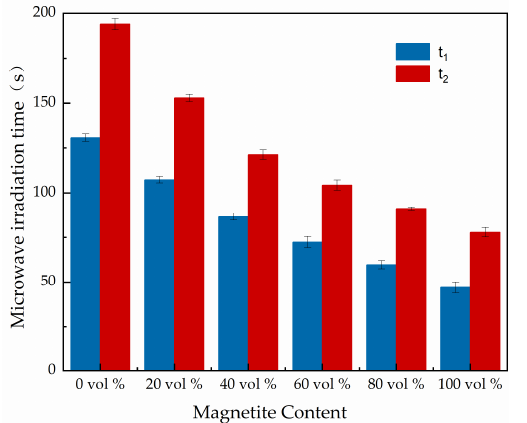
Figure 10. Experimental results of the deicing efficiency of microwave-absorbing concrete specimens with different magnetite